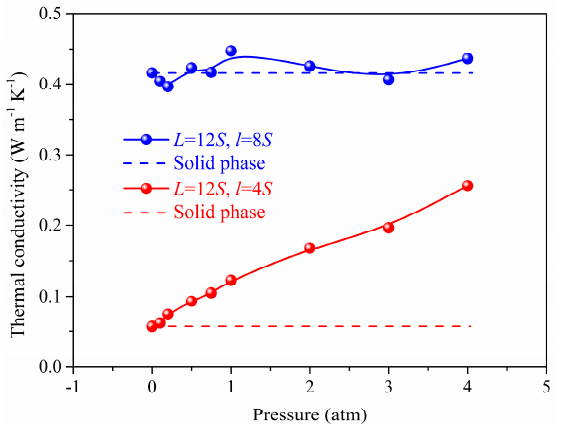
Figure 5. The thermal conductivity as a function of pressure.